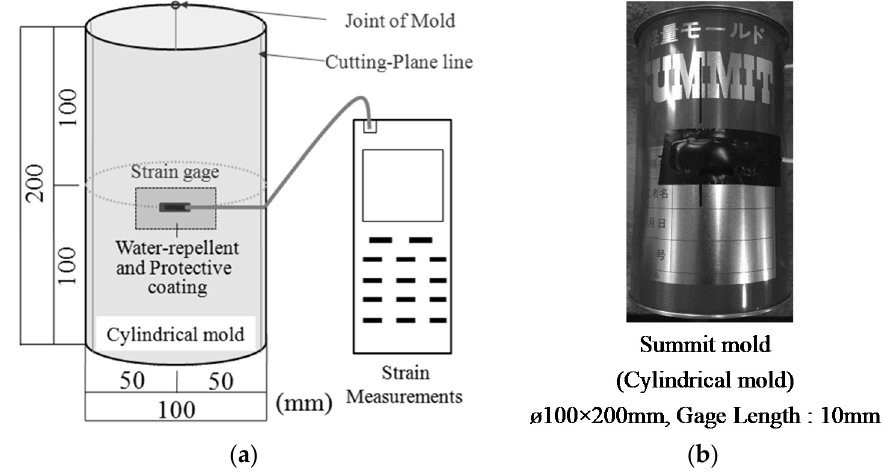
Figure 2. Overview of expansion rate test [20]. ( a ) Outline of the measurement of expansion rate; ( b ) Summit mold.